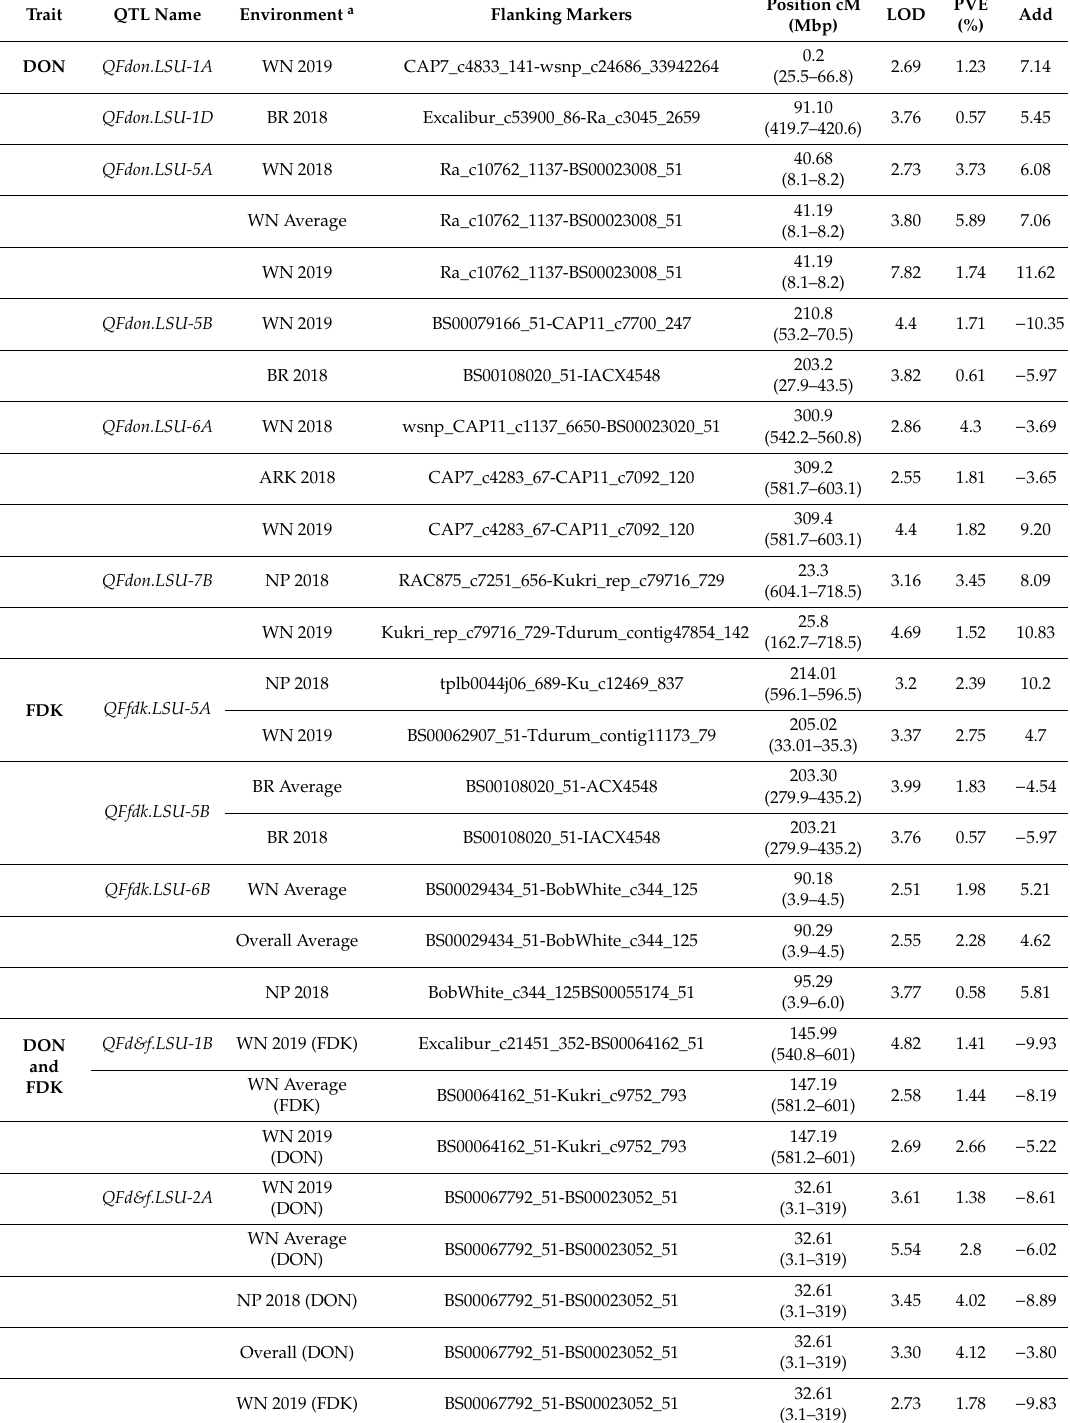
Table 6. QTLs (quantitative trait loci) associated with resistance to DON and / or FDK under di ff erent test environments in Louisiana and